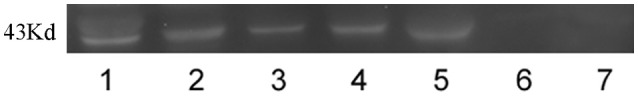
Reactivity of epitopes was analyzed with N. brasiliensis-positive mouse serum by Western blot. Lane 1–6: peptide 427–484 aa, peptide 427–482 aa, peptide 437–484 aa, peptide 447–484 aa, peptide 461–484 aa, and peptide 462–478 aa, respectively, immunoblotted with N. brasiliensis-infected mouse serum. Lane 7: MBP (negative control).